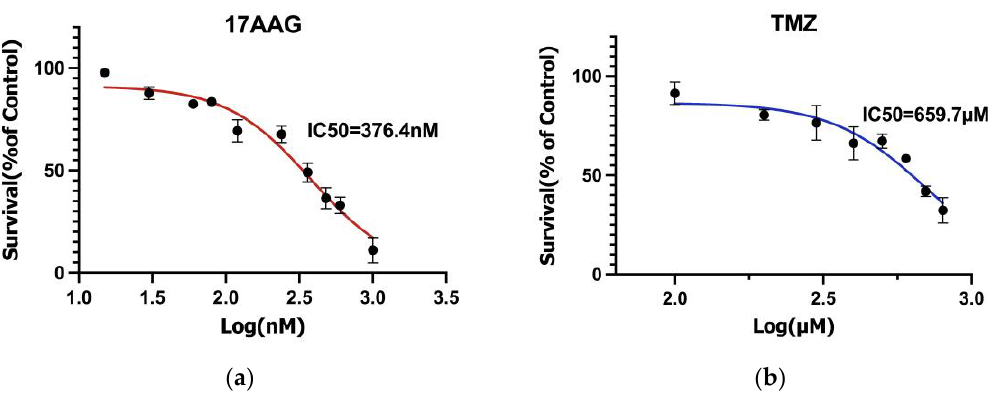
Figure 1. Drug sensitivity results of 17AAG and TMZ. ( a ) Survival curve for T98G cells with 24 h treatment of 17AAG; ( b ) Survival curve for T98G cells with 24 h treatment of TMZ. treatment of 17AAG; ( b ) Survival curve for T98G cells with 24 h treatment of